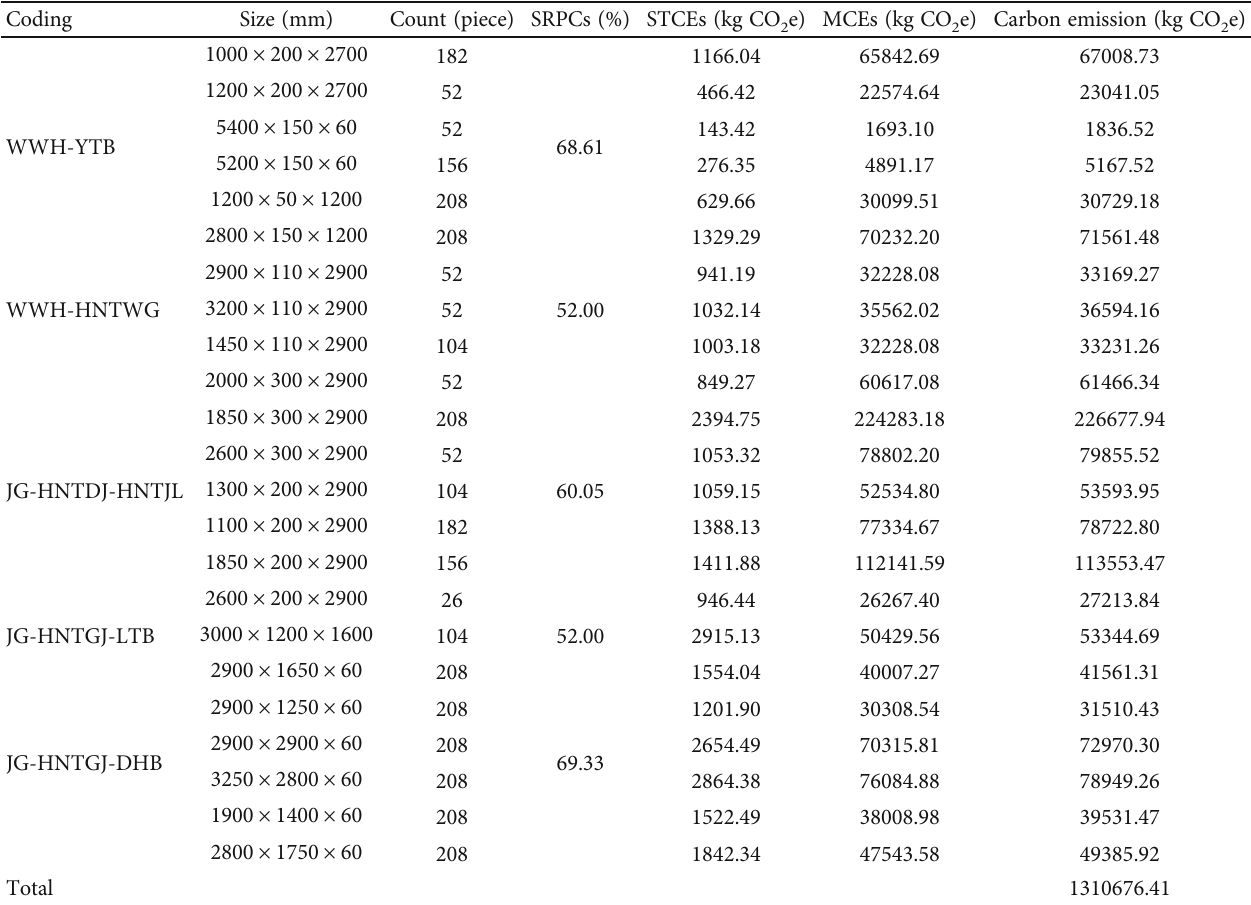
Table 2: Calculation results of prefabricated components in the case.